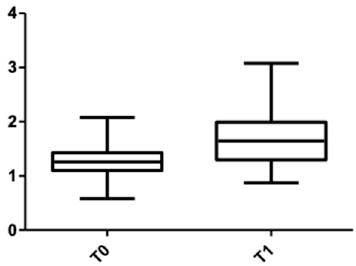
Figure 8. CBCT values at the cervical level, lower arch, at T0 and T1 for males.